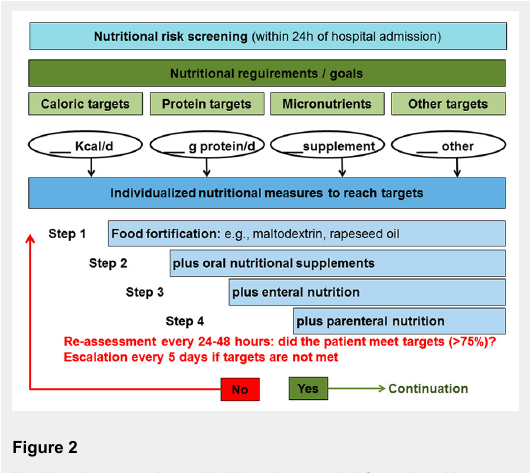
Nutritional strategy in medical inpatients at risk for